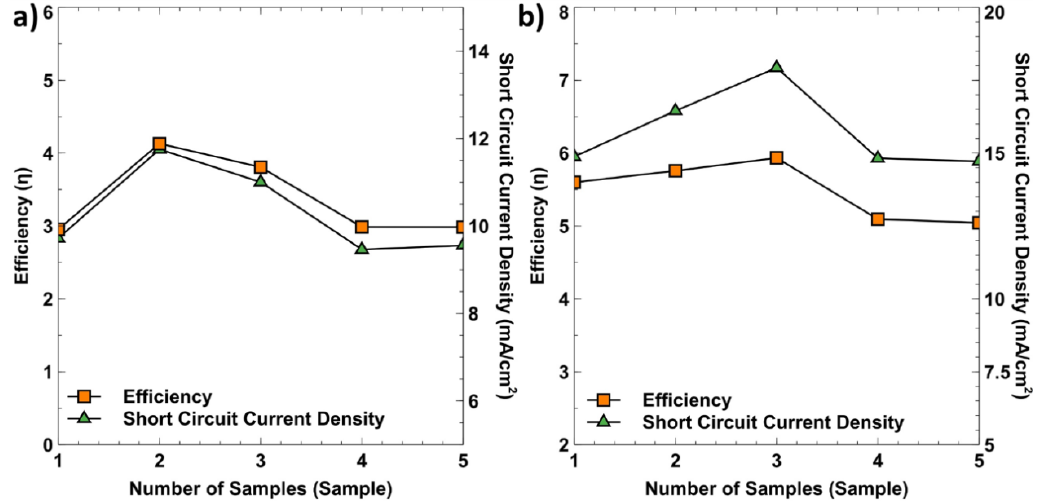
Figure 10. Power-conversion efficiency and short circuit current density for five different samples ( a ) 14.38 nm thickness of TiO 2 film and ( b ) 65.23 nm mean diameter AgNP to test the reproducibility of the DSSC devices.